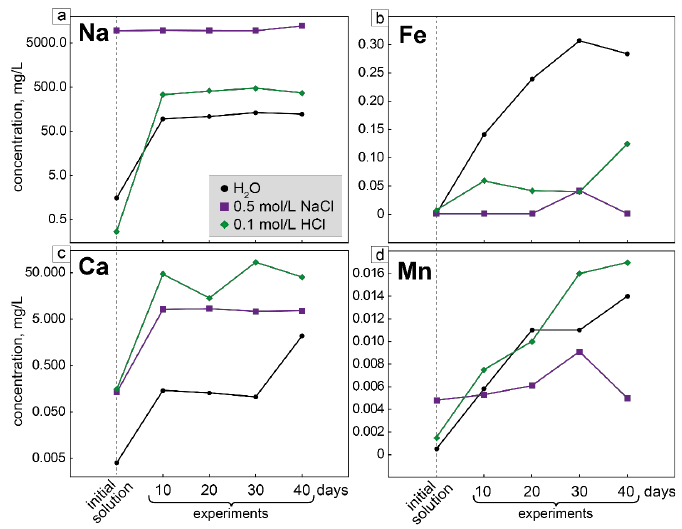
Figure 7. Changes in the composition of solutions in experiments on the partial dissolution of EGM. ( a ) Change in sodium content from the initial solutions; ( b ) change in iron content from the initial solutions; ( c ) change in calcium content from the initial solutions; ( d ) change in manganese content from the initial solutions.